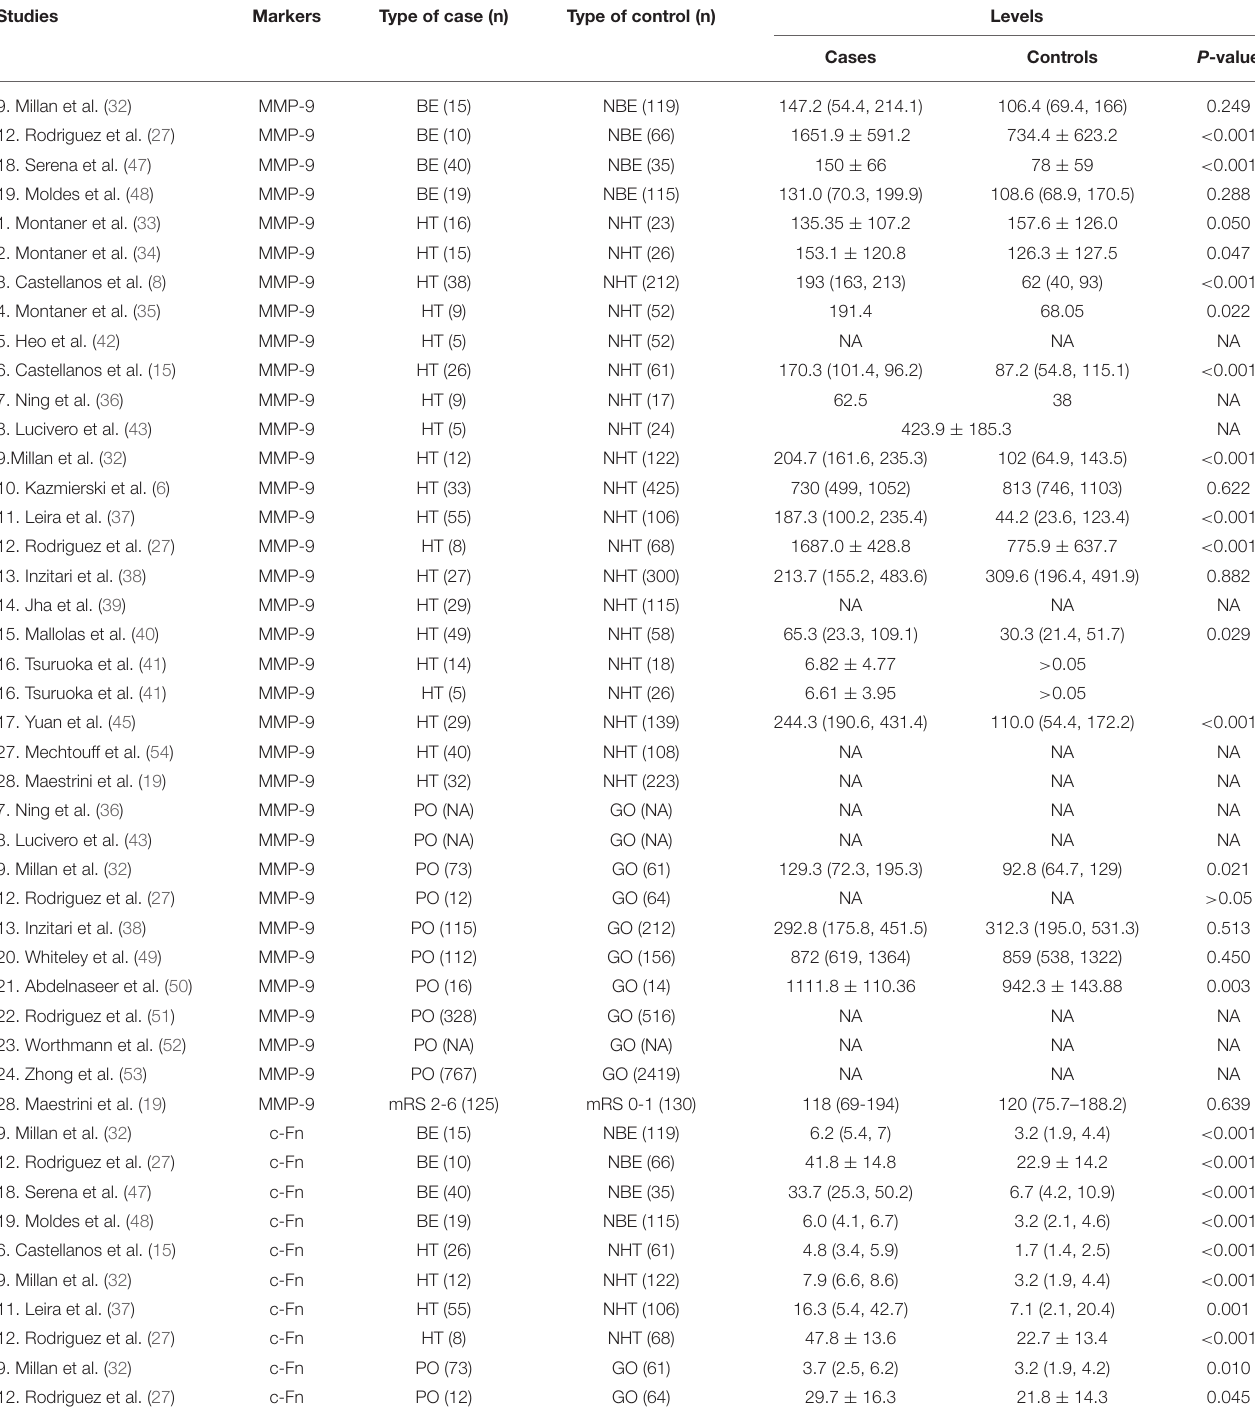
TABLE 1 | Main Results of Included Studies of association between matrix metalloproteinase-9 and cellular fibronectin and severe brain edema, hemorrhagic transformation, and poor outcome.